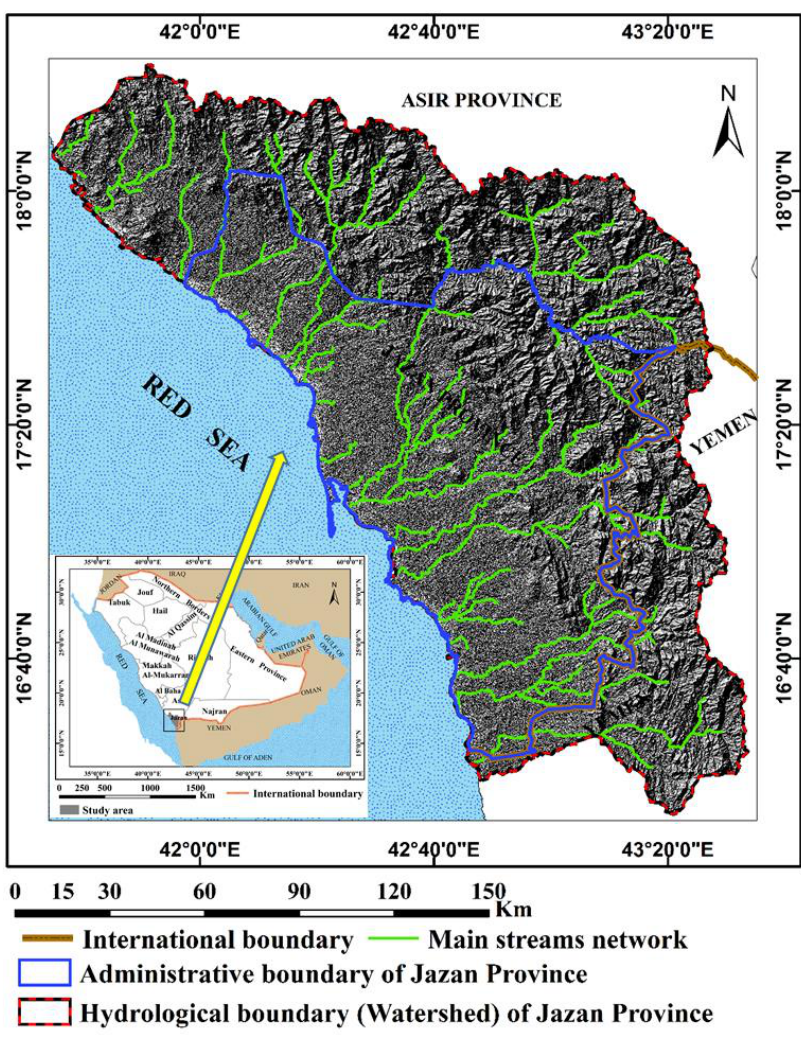
Figure 1. Location map of the study area. From a geomorphological point of view, the study area represents the western part of the Asir mountainous range, which has a topographic elevation of up to 2980 m amsl with a very steep slope at the escarpment. The drainage basins are initiated from the upstream portion (high elevated portions) and discharges the water to the western direction (Red Sea), as shown in Figure 2. The flood plains, where the main streams are filled by alluvial wadi deposits, are considered to be the main portion of the shallow Quaternary unconfined aquifer of the study